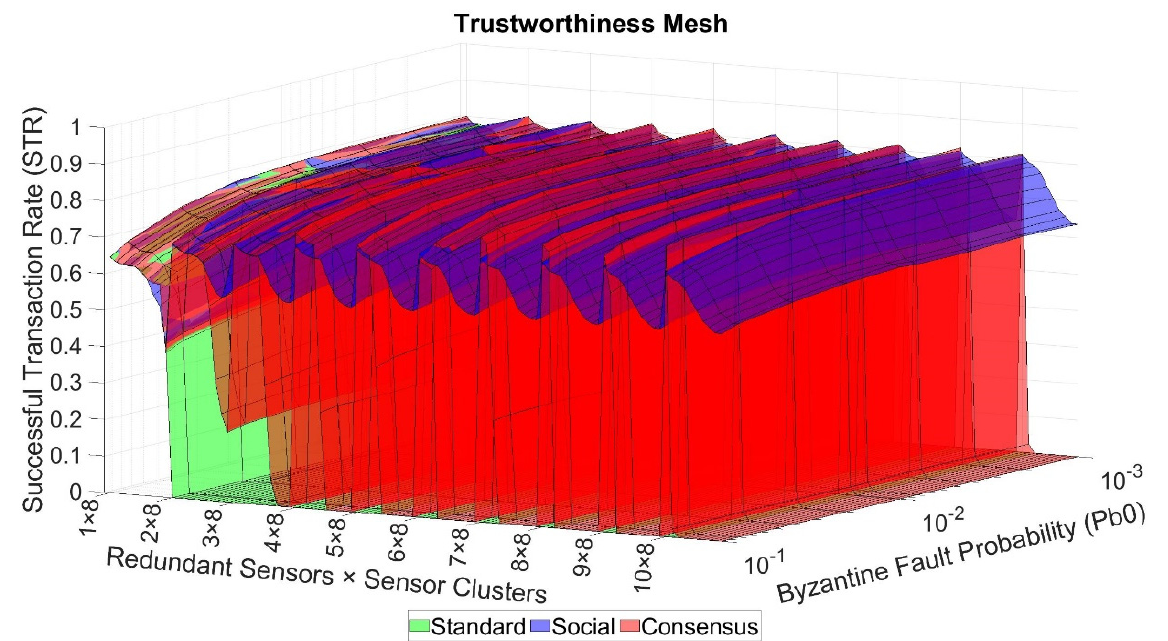
Figure 5. Trustworthiness mesh graph for the standard operational mode (green), the redundancy mode with Social Trustworthiness (blue), and the redundancy mode with Consensus mechanism (red).